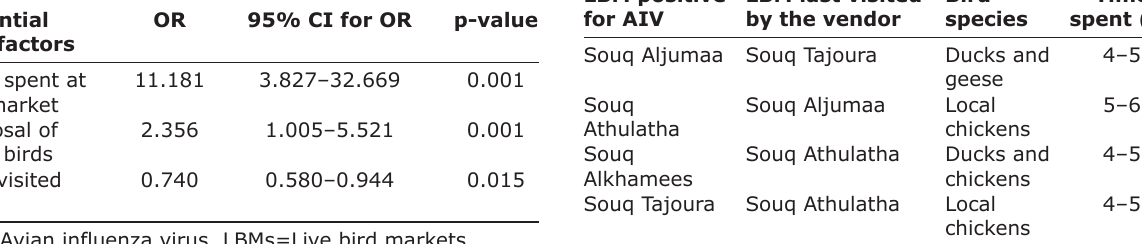
AIV contamination of LBMs. Potential risk factors